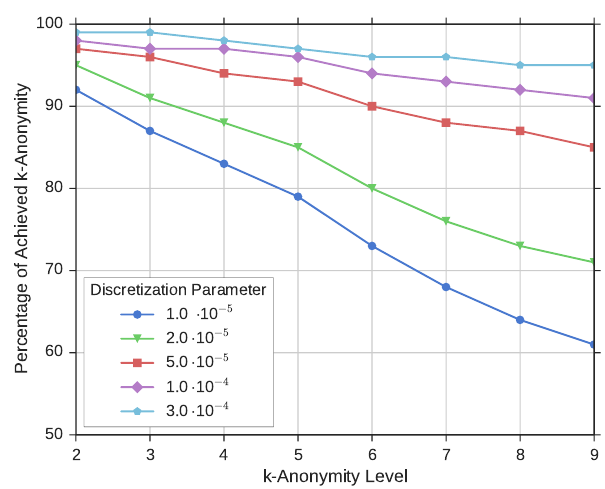
Figure 4. K-anonymity in dependency of validity discretization, depicting the decrease of anonymity with smaller discretization